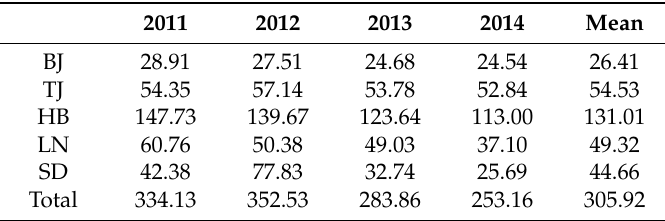
Table 5. Changes after maximum potential reduction of COD discharge in Bohai Bay city agglomeration (in kilotons),